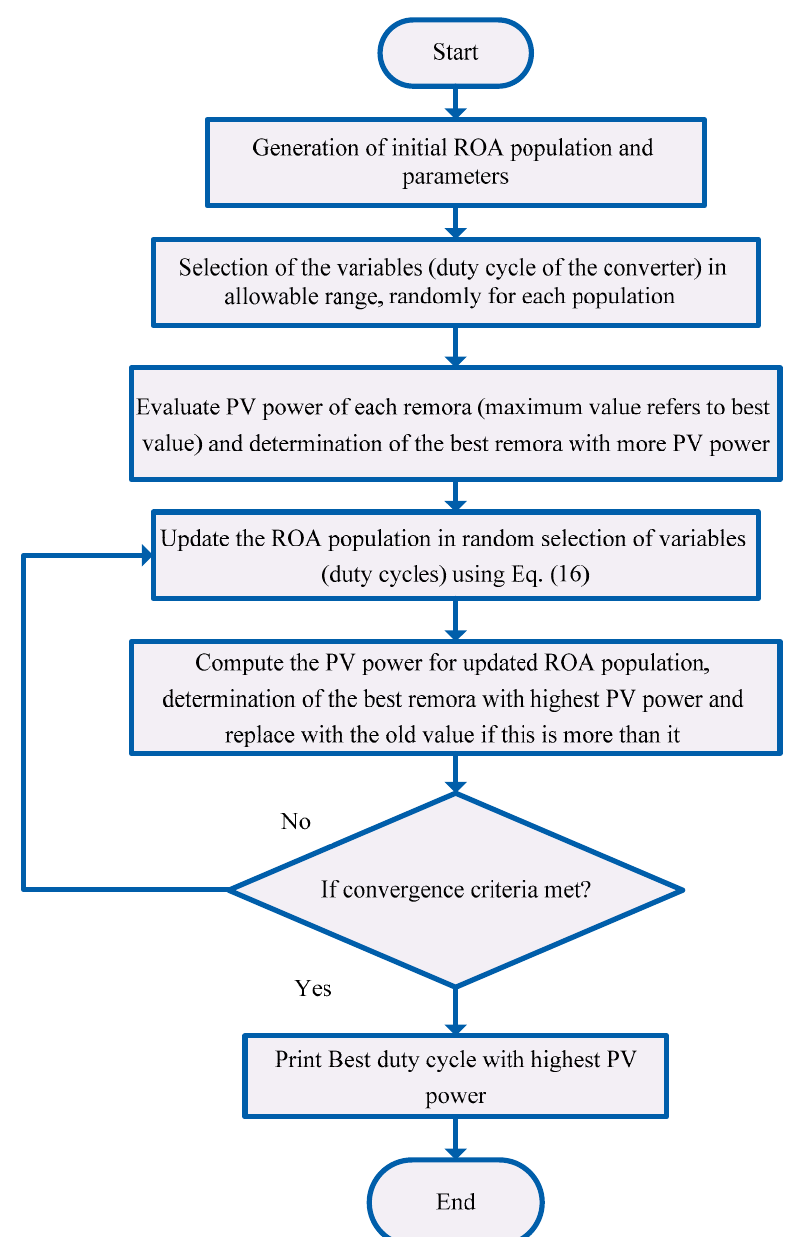
Figure 5. Flow chart of ROA implementation in proposed MPPT solutions.